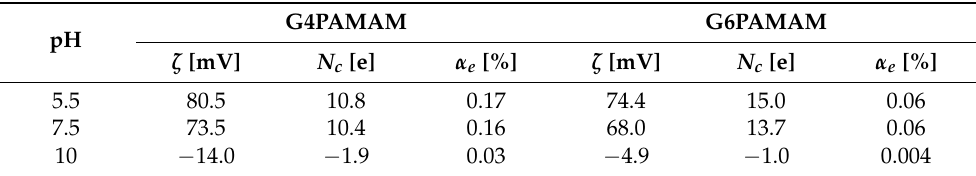
Table 1. Zeta potential ( ζ ), effective charge (N c ) and effective degree of ionization ( α e ) for